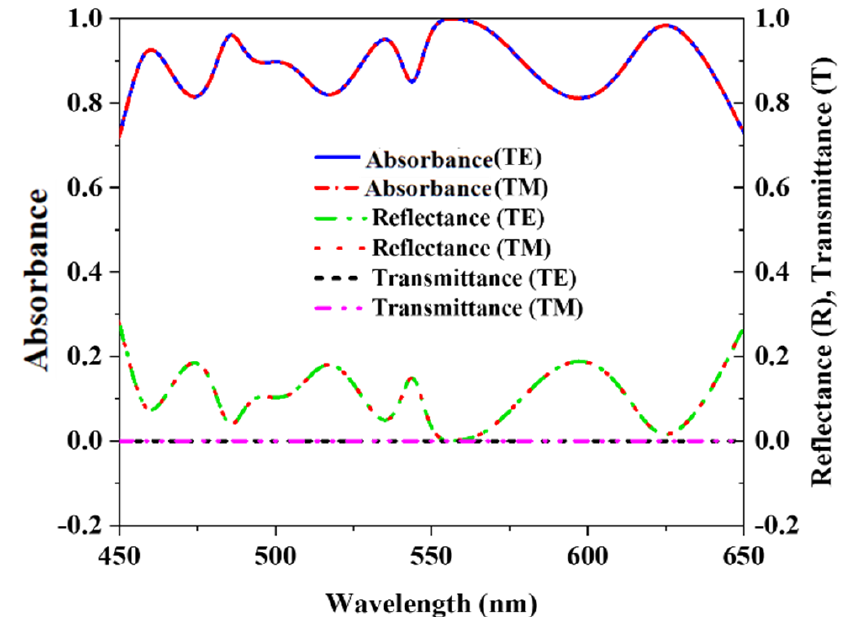
Figure 5. Reflectance, Transmission, and Absorbance plot.